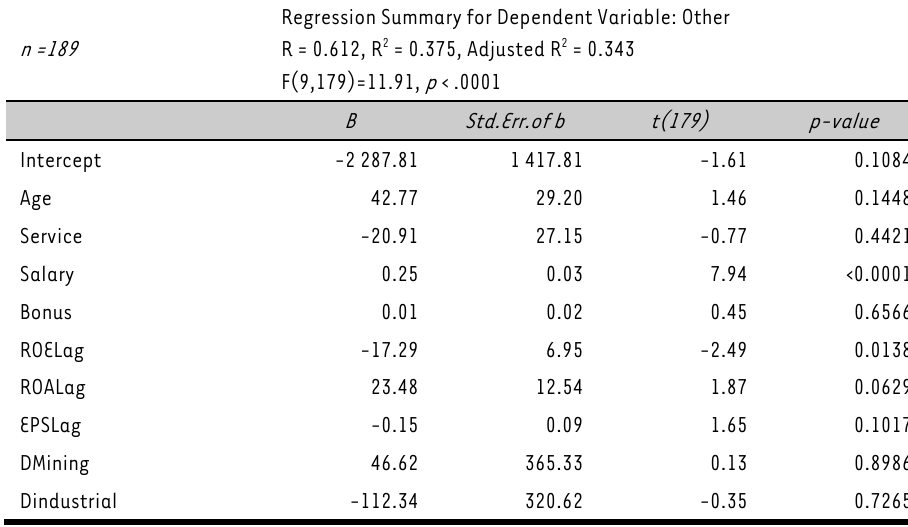
TABLE 6: Econometric Model 3 showing ‘other’ remuneration as the dependent variable with lagged ROE, ROA and EPS Regression Summary for Dependent Variable: Other n =189 R = 0.612, R 2 = 0.375, Adjusted R 2 = 0.343 F(9,179)=11.91, p < .0001 B Std.Err.of b t(179) p-value -2